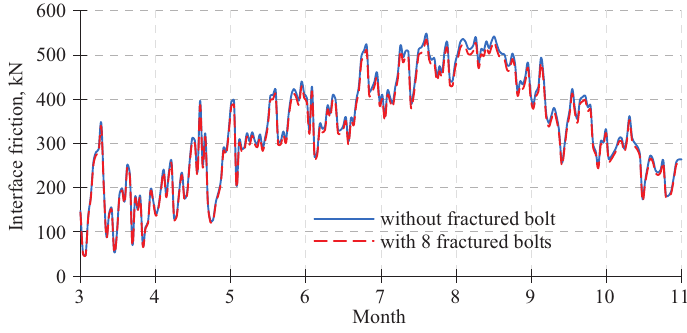
Figure 17. The friction force in the area